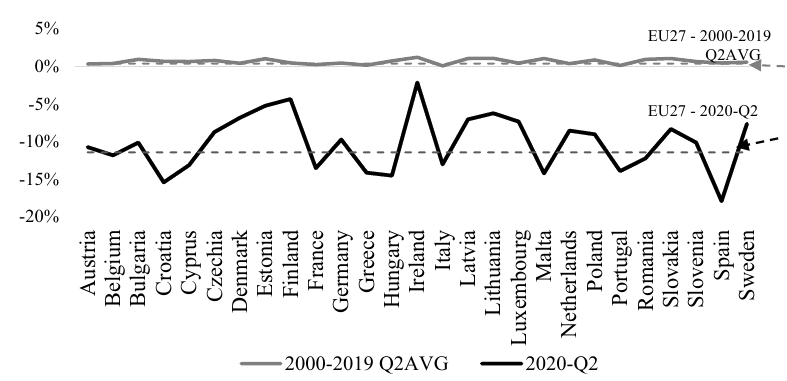
Figure 5: Q2 - GDP evolution for EU 27 countries. Source: Authors ’ elaboration based on data from Eurostat.